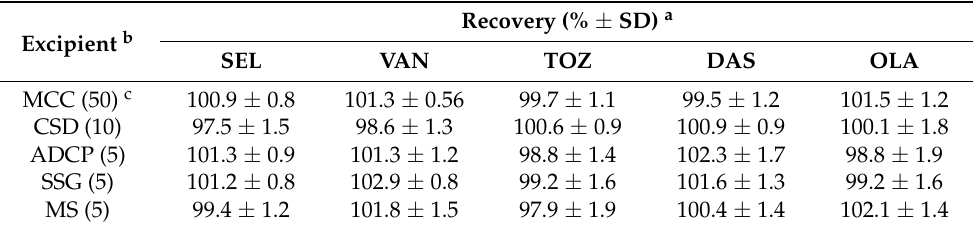
Table 7. Analysis of TKIs in the presence of the excipients in solid pharmaceutical tablets by the proposed 96-microwell spectrophotometric assay based on their CT reactions with CLA.